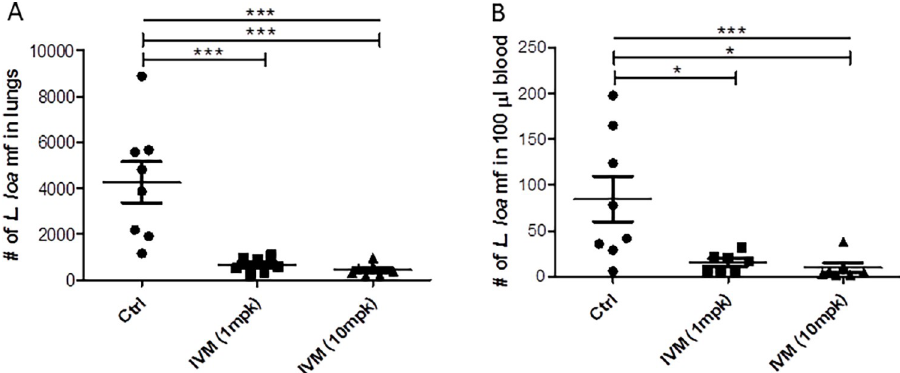
Fig 3. Ivermectin significantly decreases L . loa mf in BALB/c mice. Mice (males and females) were infected intravenously with 40,000 L . loa mf. After 12 hours, mice were orally treated with 1 or 10 mg/kg body weight IVM. Control animals received vehicle (1% DMSO in PBS). Mice were analyzed 2.5 days post-infection for L . loa mf in (A) Lungs, and (B) Cardiac blood. � P < 0.05, ��� P <